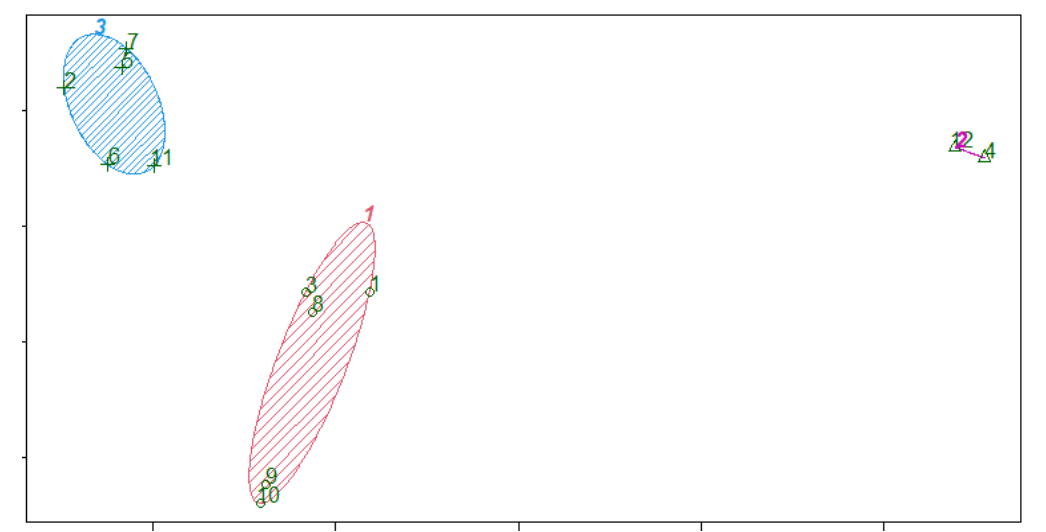
Figure 5. Clustering of the initial data by the k-means method.